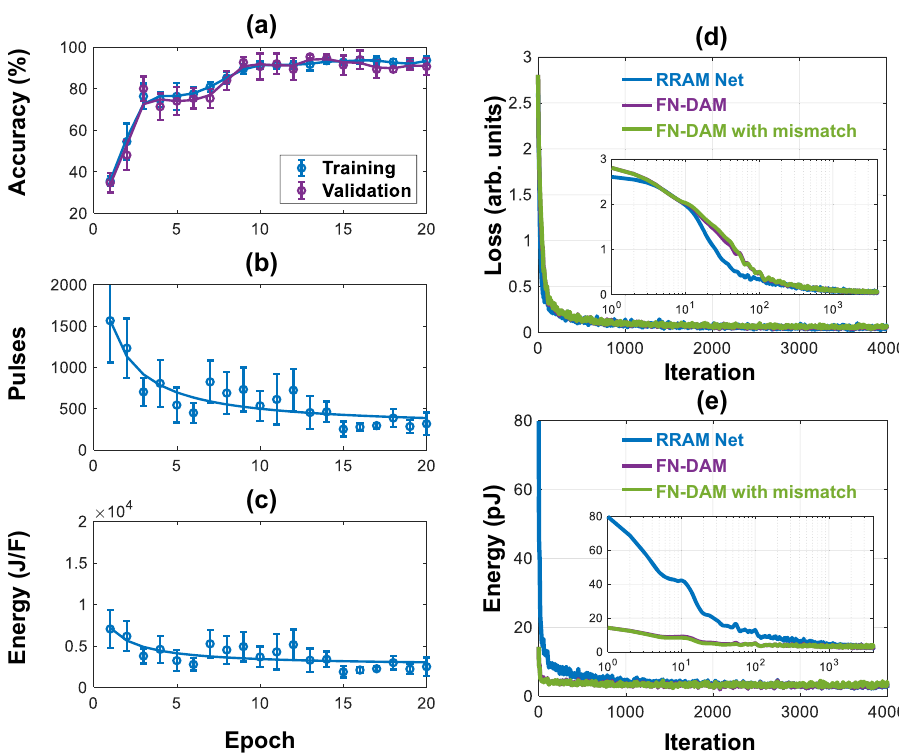
Fig. 6 Synaptic memory for deep neural network tasks. a – c Experimental training on Fisher Iris dataset over fi ve trials: a Five-fold cross-validation accuracy of model over 20 epochs for training set (120 points) and validation set (30 points). b Total pulses required in implementing weight update for entire synaptic array during each epoch. c Energy per unit capacitance expended in updating the weights. Note: scale of Y -axis is set to match that of panel ( b ). Error bars in a – c indicate standard deviation estimated across fi ve trials. d , e Simulated training on MNIST dataset: d Network loss for three types of network models. Inset shows same data with x -axis in log scale. e Energy dissipated in updating the network weights for three types of network models. Inset shows same data with X -axis in log scale. Table 1 Test accuracy obtained for different variants of CNNs on the MNIST